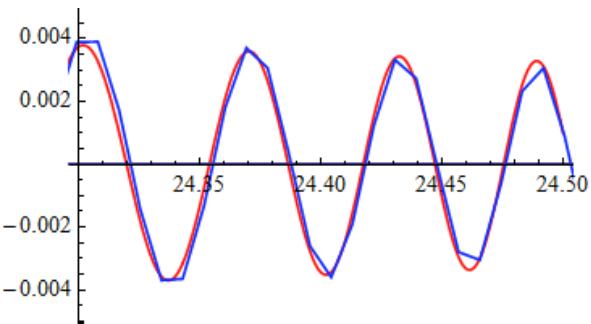
Figure 7. Fragment of oscillating u ( x ) in the interval 24.3 < ln x < 24.5 derived analytically (54) (red line) and found numerically (blue line). The angularity of the blue line is due to the fact that the condensing oscillations in the huge interval ( x m , x h ) are obtained at the limit of computer accuracy.